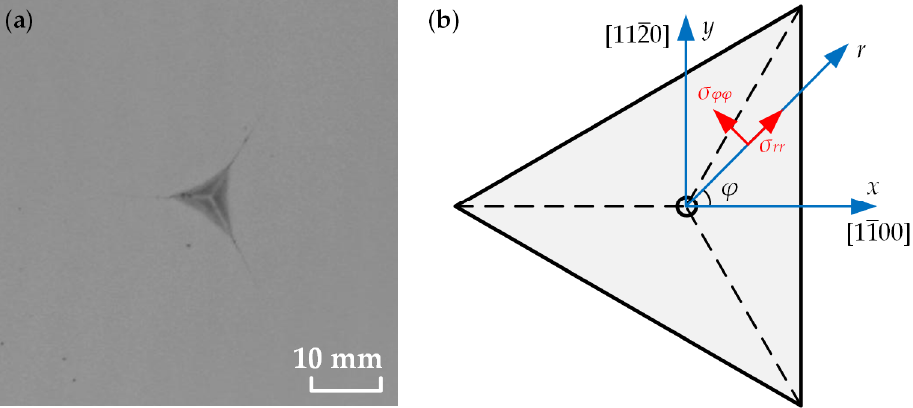
Figure 7. ( a ) Microphotograph of a nanoindentation on the (0001) plane; ( b ) sample, crystal and cylindrical coordinate systems on the (0001) plane.